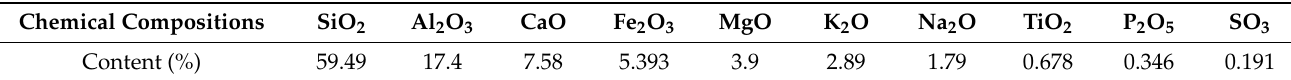
Figure 1. Testing instruments: ( a ) X-ray fluorescence analyzer; ( b ) X-ray diffractometer. Table 1. Main components of